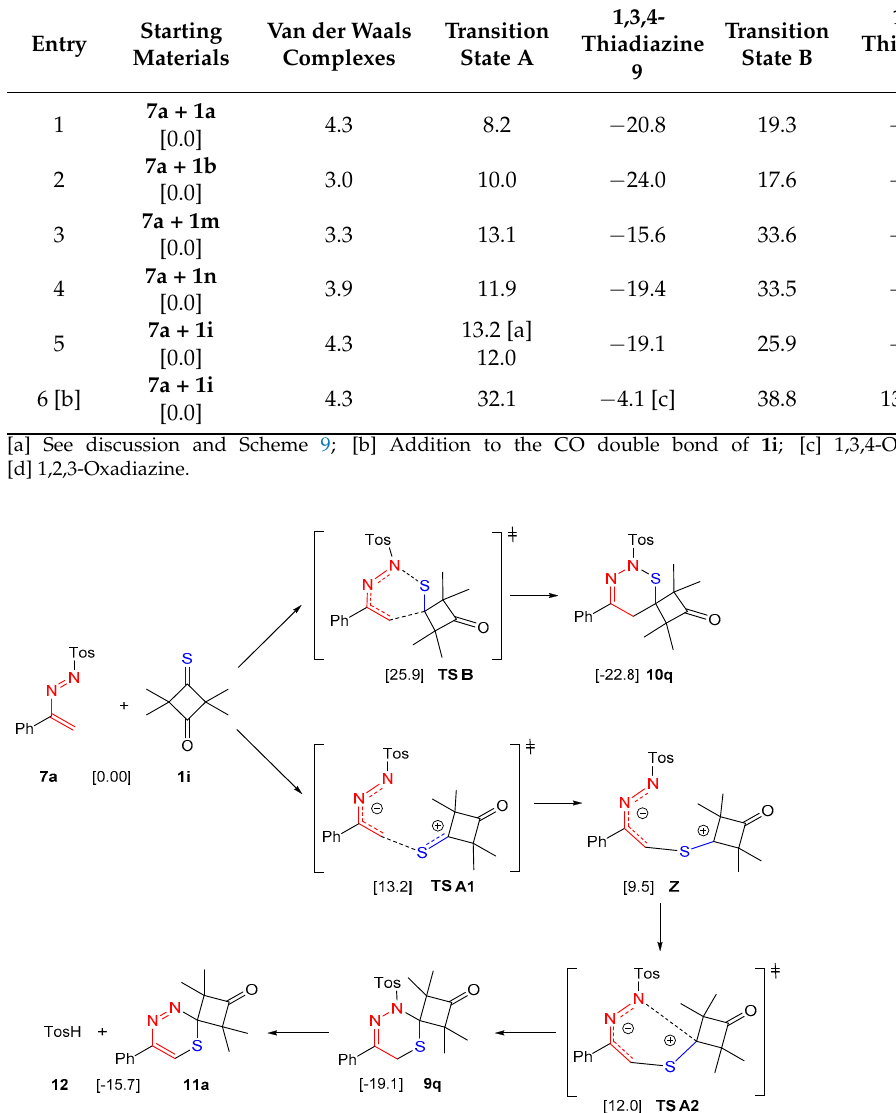
Table 1. DFT calculations of the cycloadditions of azoalkene 7a with different thioketones 1 (Gibbs free energies ( ∆ G 298 ) in kcal/mol).